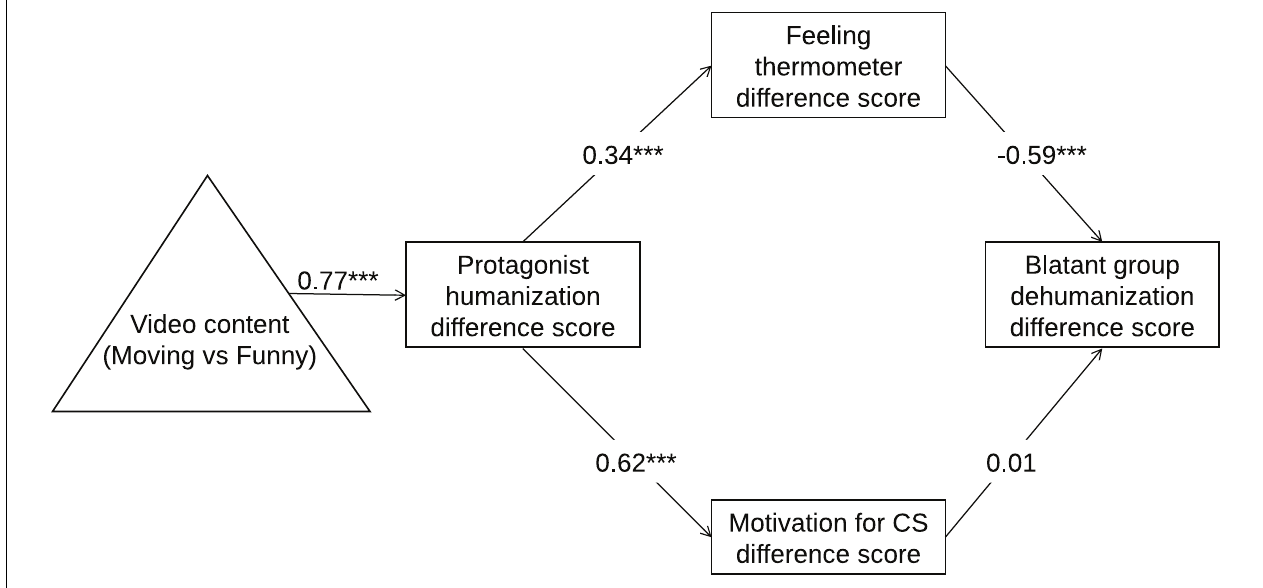
FIGURE 4 | A within-participant serial mediation model from Study 2, with standardized estimates. The direct effect of video content on blatant group humanization (c’) was not significant, B = –0.07, p = 0.247, whereas a total effect (c) was significant, B = –0.19, p = 0.003. *** p <